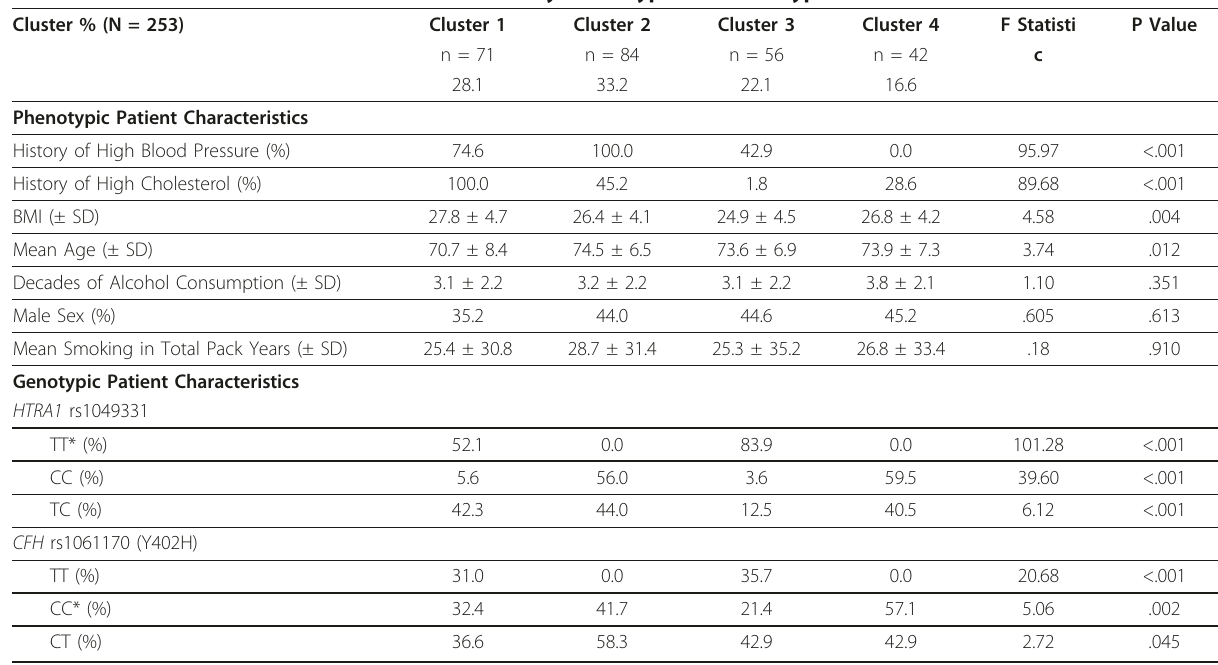
Table 1 Neovascular AMD Patient Clusters Defined by Phenotypic and Genotypic Risk